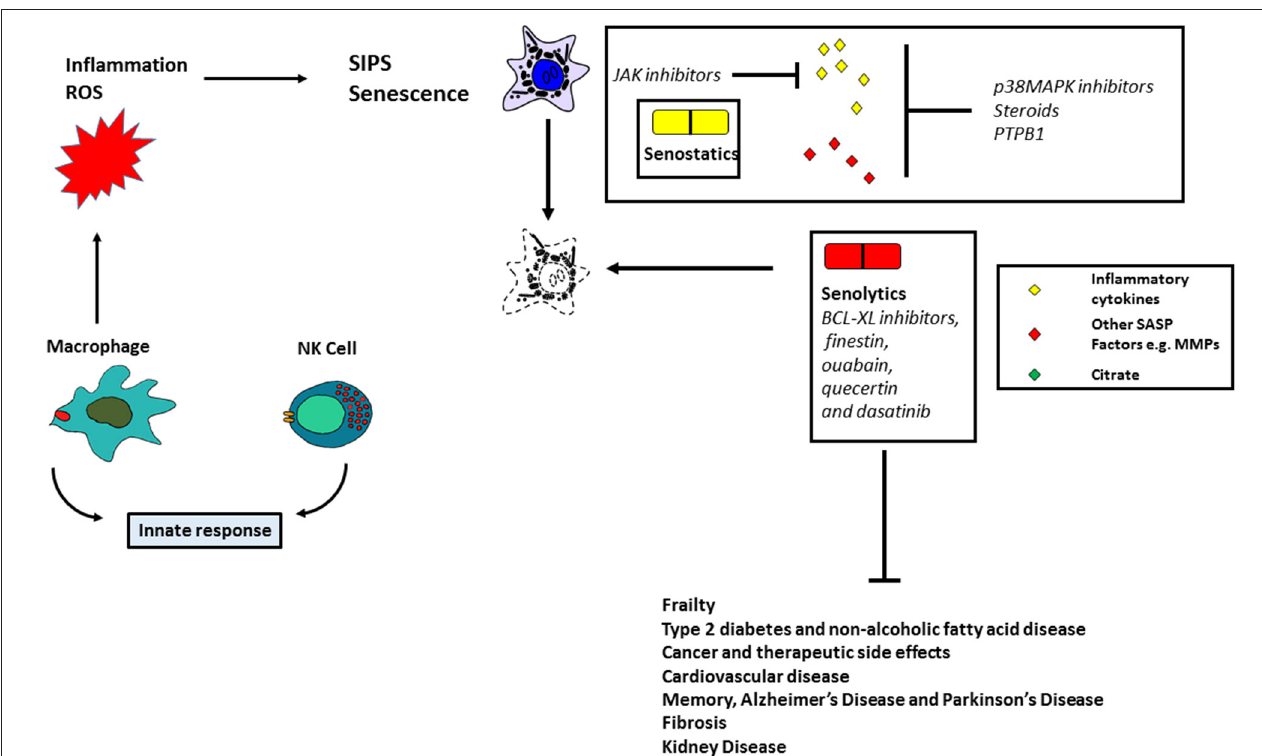
FIGURE 2 | Targeting senescent cells therapeutically. The figure summarizes the instrumental role of senescent cells in human pathologies and the potential role of antioxidant, senostatic, and senolytic